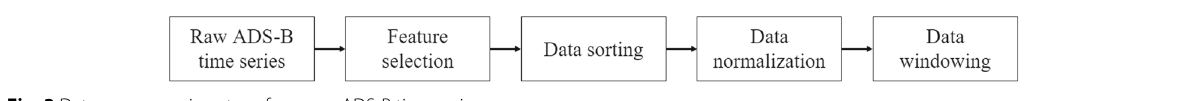
Fig. 3 Data preprocessing steps from raw ADS-B time